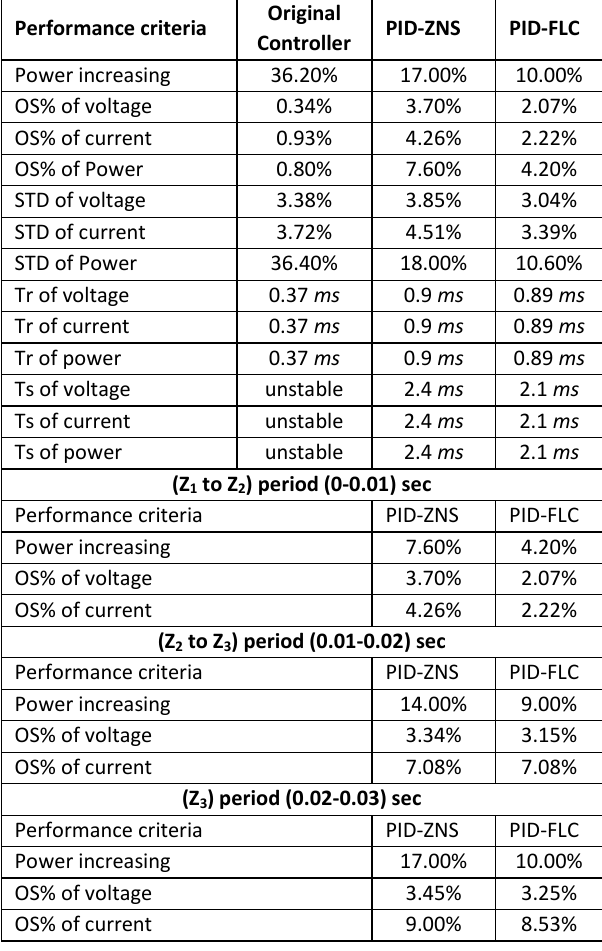
Table 2: Summary of